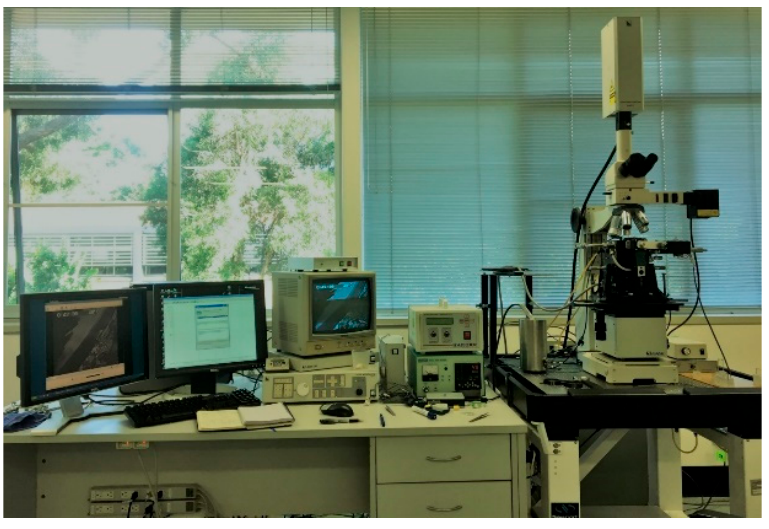
Figure 1. Picture of HTCM 1LM21H.